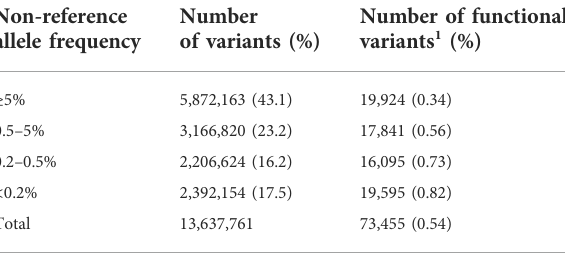
TABLE 1 Spectrum of variants in the Korean Reference Genome reference panel (pilot